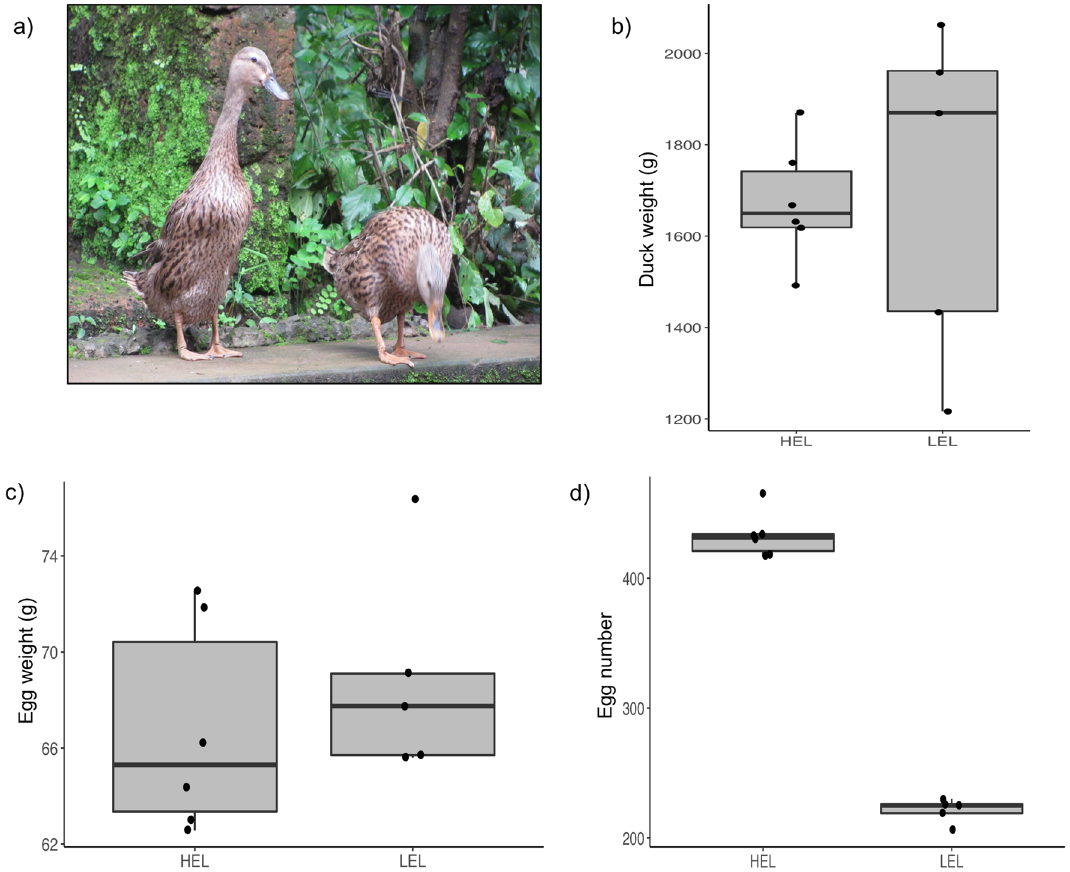
Figure 1. The phenotypic characteristics of HEL and LEL ducks. ( a ) Chara duck ( b ) Box plot showing the body weight distribution of HEL and LEL ducks ( c ) Box plot showing the egg weight distribution of HEL and LEL ducks ( d ) Box plot showing the total number of eggs laid by the HEL and LEL